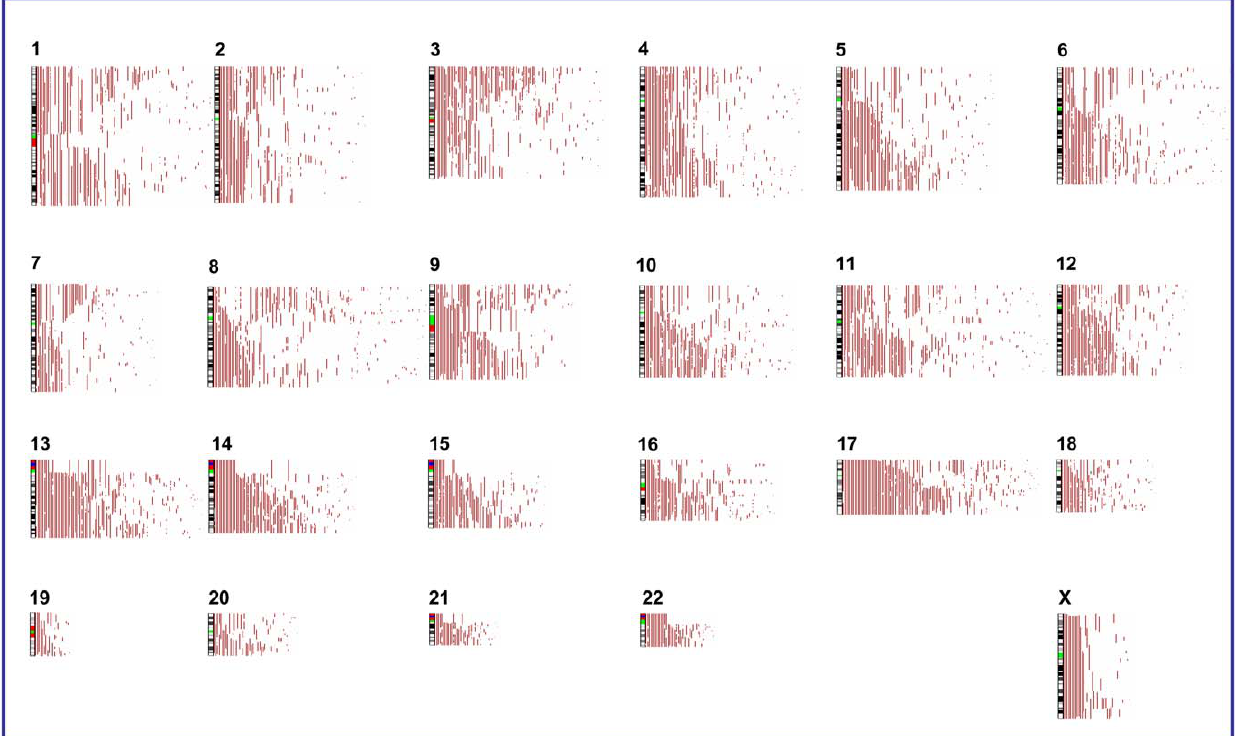
Figure 1. Distribution of aUPD in breast cancer samples.